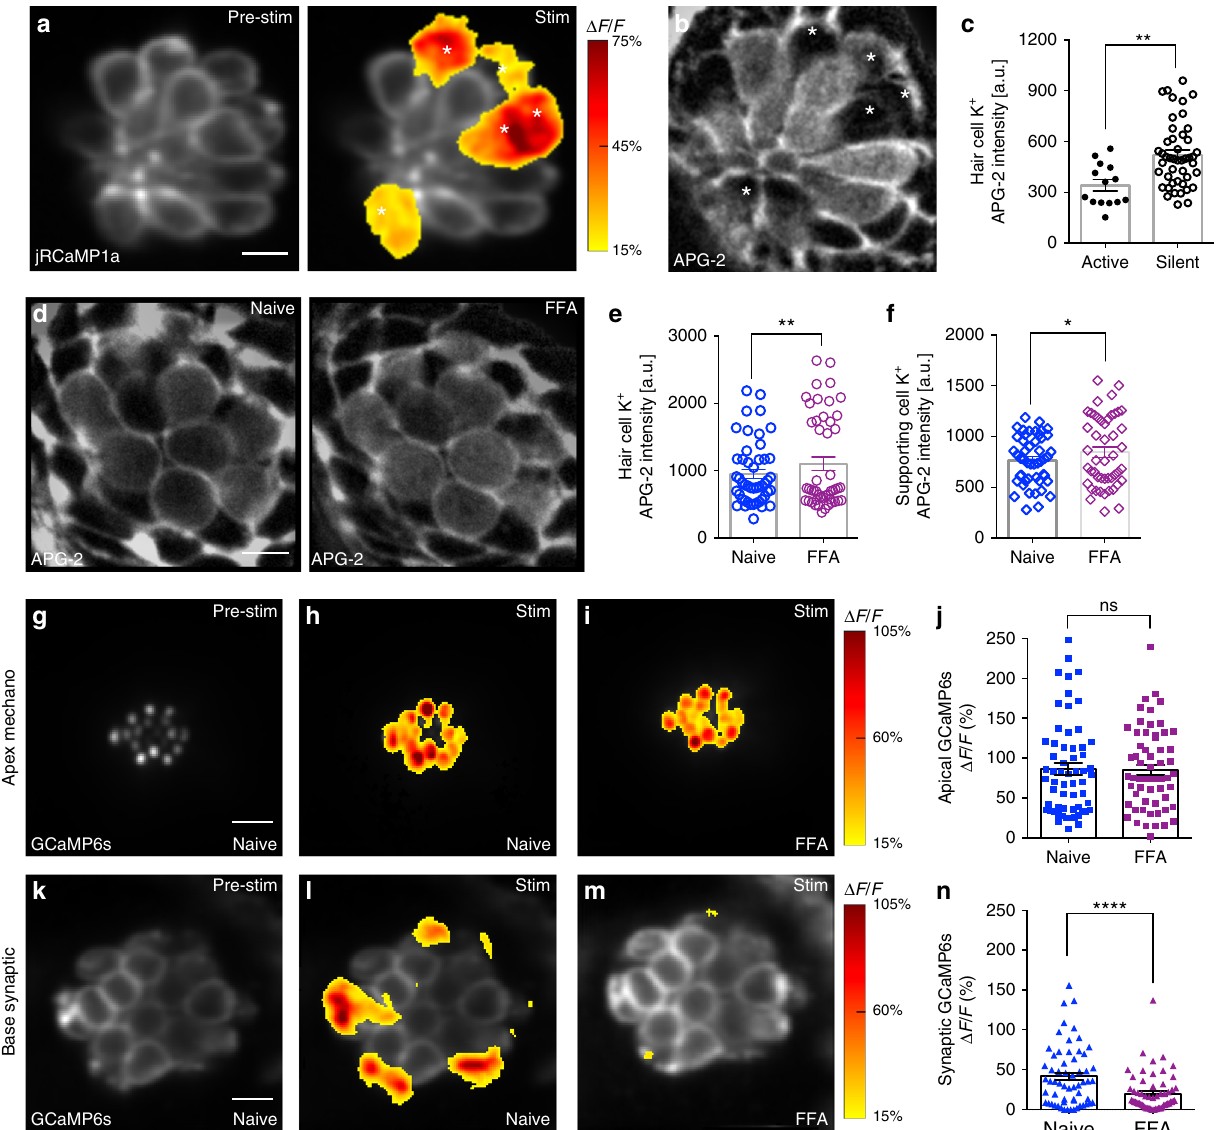
Fig. 5 Low [K + ] and gap junctions may facilitate presynaptic activity. a Presynaptic Ca 2 + jRCaMP1a Ca 2 + signals during a 2-s 5 Hz stimulus. Spatial patterns of jRCaMp1a Ca 2 + signals during stimulation are colorized according to the Δ F / F heat maps and superimposed onto a pre-stimulus baseline jRCaMP1a image ( a , left panel). b Image of the same neuromast as a after labeling with the K + indicator, APG-2. The active cells in a and b are marked with asterisks. c Quanti fi cation of APG-2 intensity shows that active cells (341.1 a.u. ± 33.17, n = 14 cells) have lower resting [K + ] in levels than silent cells (520.1 a.u. ± 28.37, n = 46 cells) p = 0.001. d APG-2 dye labeling before ( d , left panel) and after ( d , right panel) FFA treatment to block gap junctions. e , f Quanti fi cation of APG-2 intensity shows 25 µ m FFA signi fi cantly increases [K + ] in levels in hair cells (naïve: 950.2 a.u. ± 67.9; after FFA: 1105 a.u. ± 99.7, n = 48 cells, p = 0.01) and in supporting cells (naïve: 767.1 a.u. ± 34.4; after FFA: 845.1 a.u. ± 50.3, n = 48 cells, p = 0.015). g – i , k – m Mechanosensitive and presynaptic GCaMP6s Ca 2 + signals within the same cells before and after application of 25 μ M FFA. Mechanosensative ( h ) and presynaptic ( l ) Ca 2 + signals during a 2-s 5 Hz stimulus prior to drug treatment; 25 μ M FFA does not alter mechanotransduction ( i ) but decreases presynaptic Ca 2 + responses ( m ). Spatial patterns of GCaMP6s Ca 2 + signals during stimulation are colorized according to the Δ F / F heat maps and superimposed onto baseline GCaMP6s images ( g , k ). j Quanti fi cations of the mechanosensitive Ca 2 + signals show no signi fi cant differences before (86.10% ± 7.55) and after 25 μ M FFA (85.18%± 6.64), n = 60 hair cells, p = 0.76. n In the same cells as j , presynaptic Ca 2 + signals (41.55% ± 4.85) are signi fi cantly decreased after FFA application (20.27% ± 3.07), n = 60 cells, p < 0.0001. A Mann – Whitney test was used in c , a Wilcoxon test was used in e , f , j , and n ; * p < 0.05, ** p < 0.01, **** p < 0.0001. Scale bars = 5 μ